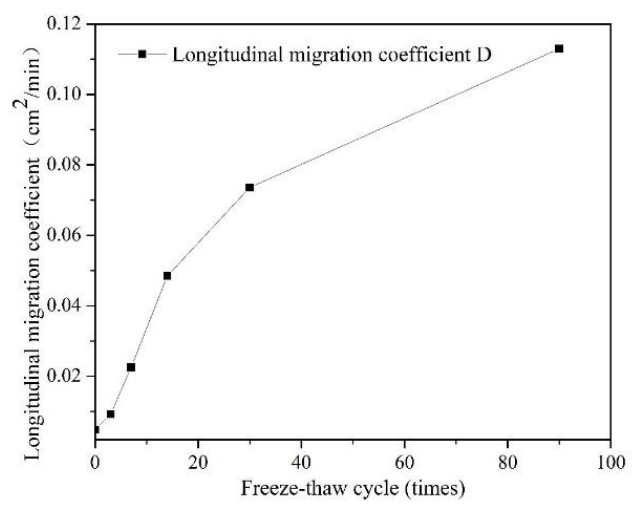
Figure 10. Variation of longitudinal migration coefficient (D) of Br − 1 in S/S lead-zinc-cadmium Figure 10 . Variation of longitudinal migration coefficient (D) of 𝐵𝑟 −1 in S/S lead-zinc-cadmium composite HM-contaminated soil with F-T cycles. composite HM-contaminated soil with F-T cycles.